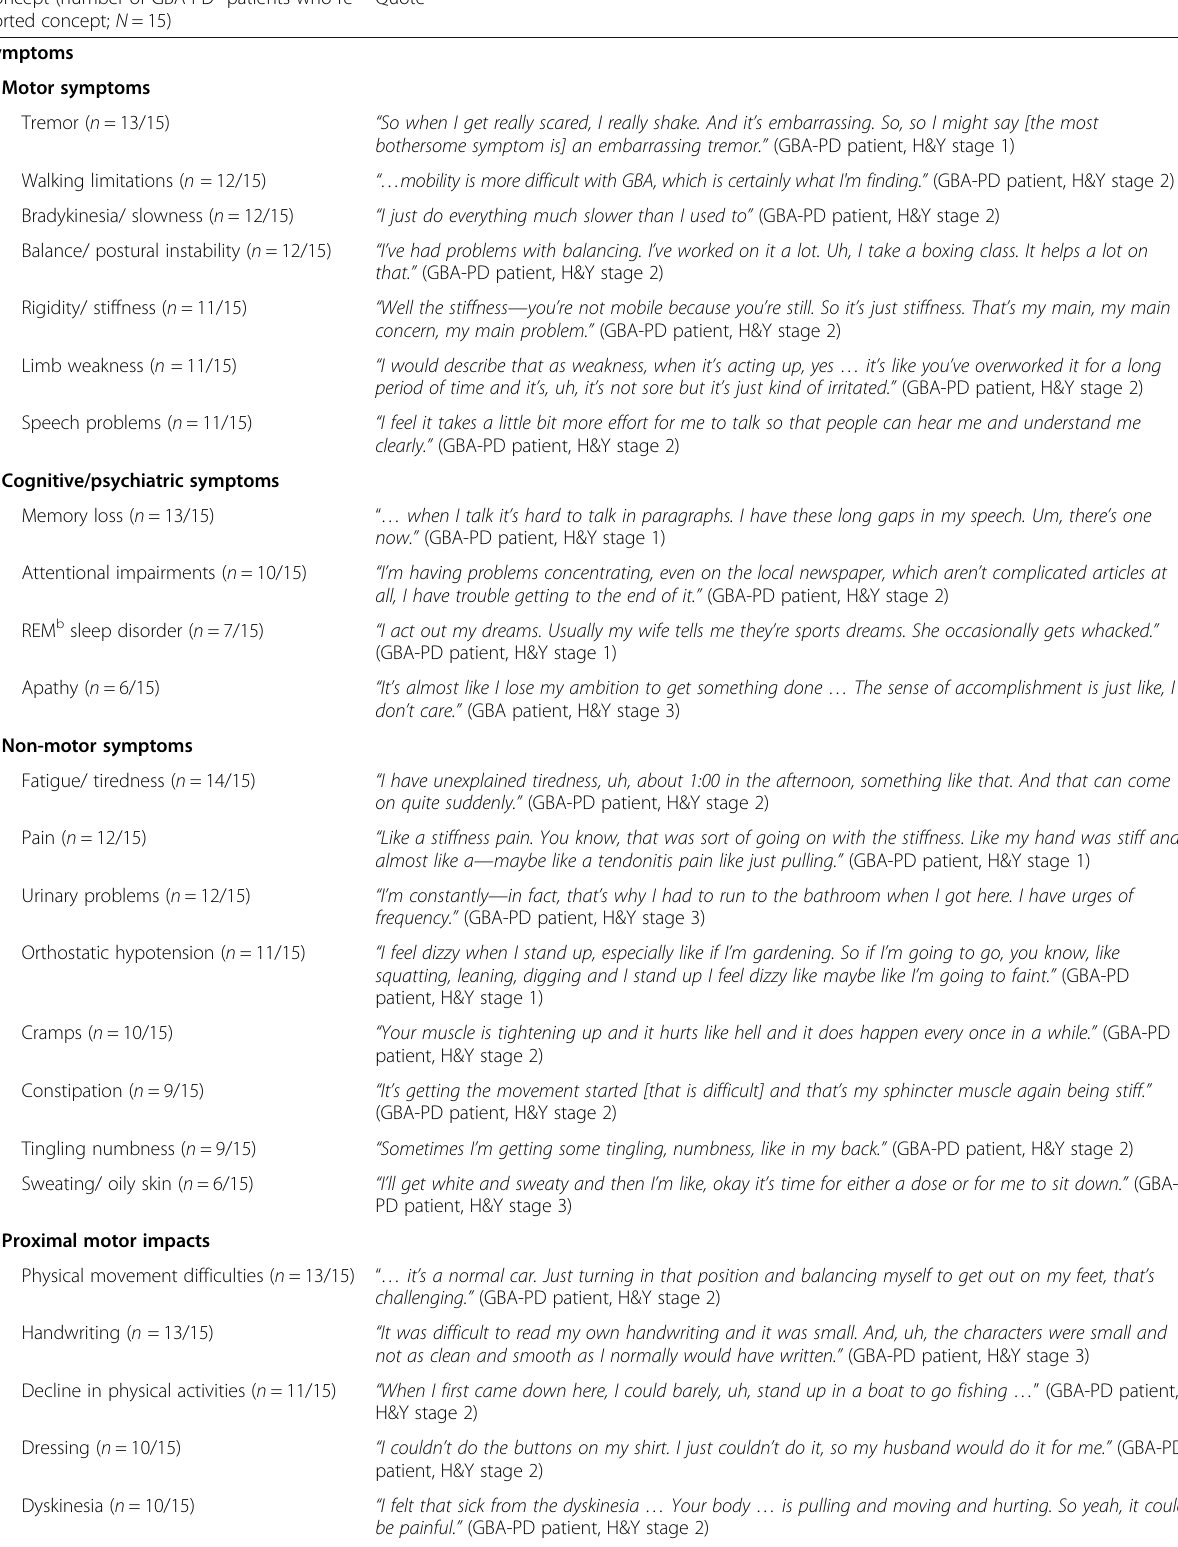
Table 4 Summary of symptom and proximal impact concepts reported by ≥ 5 GBA-PD a participants Concept (number of GBA-PD a patients who re- ported concept; N =